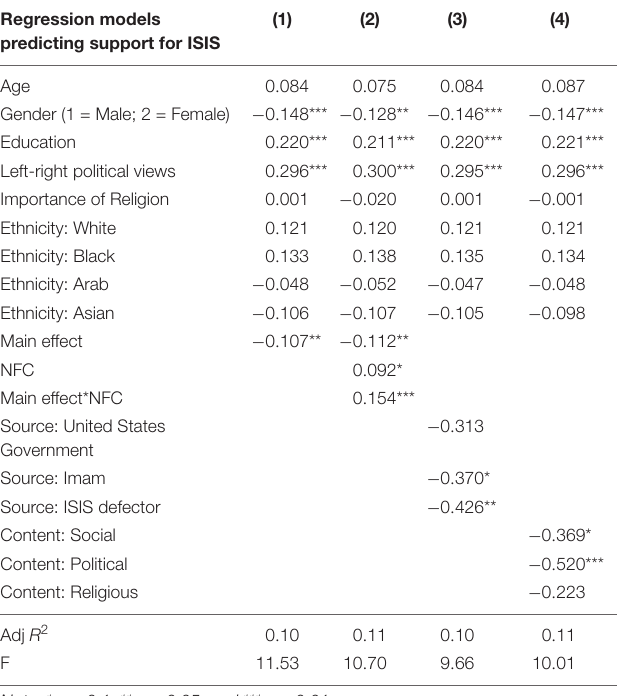
TABLE 2 | Standardized regression coefficients predicting support for ISIS ( N = 886). Regression models predicting support for